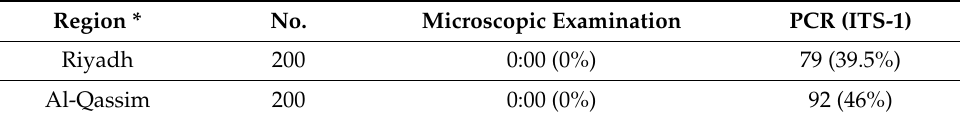
Figure 1. ( A ) Blood smear from camel was free of visible infection with Trypanosoma spp. ( B ) Agarose gel (1.5%) electrophoretogram with 100-bp DNA ladder. PCR analysis of the ITS-1 gene revealed a 500 bp band derived from T. evansi isolates from different camels (lanes 1–7). Table 2. Prevalence of T. evansi in camels from Riyadh and Al-Qassim.